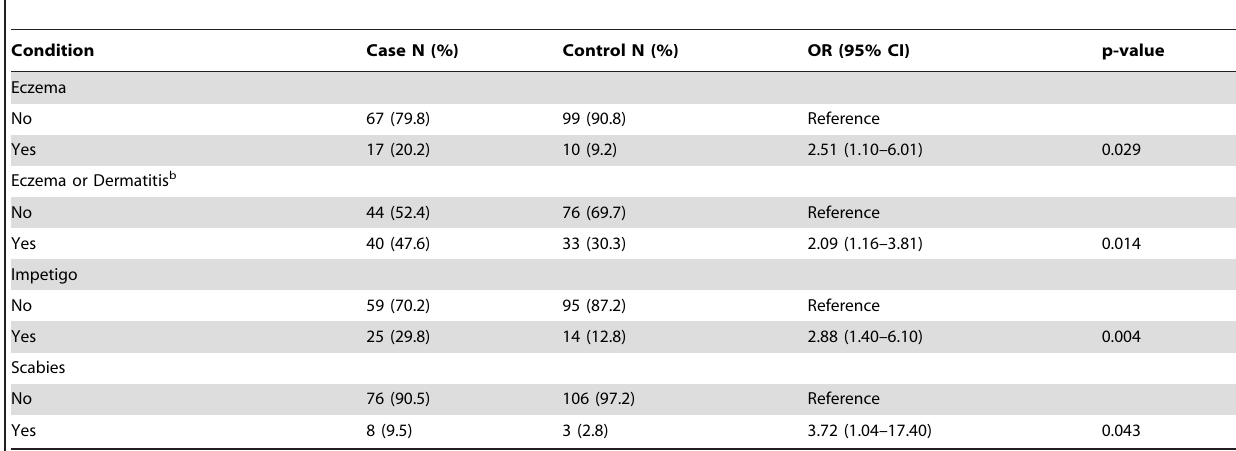
Table 3. Univariate analysis of prior dermatological conditions for American Indian molluscum contagiosum (MC) cases and control patients , 5 years of age at facility B. a